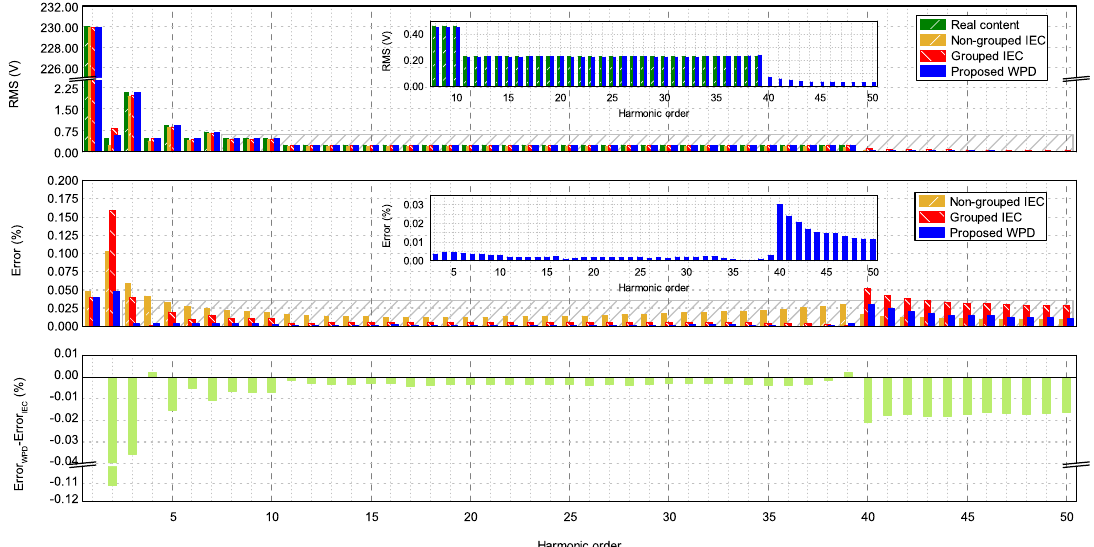
Figure 3. Analysis of the IEC 61000-3-2 limits waveform under stationary conditions. The comparison is made between the IEC, the grouped IEC, and the proposed WPD methods. The upper graph shows the spectrum of the RMS content of each IEC frequency band for the three methods, compared to the real content. The middle graph shows the errors for each frequency band. The difference between the errors is shown in the bottom